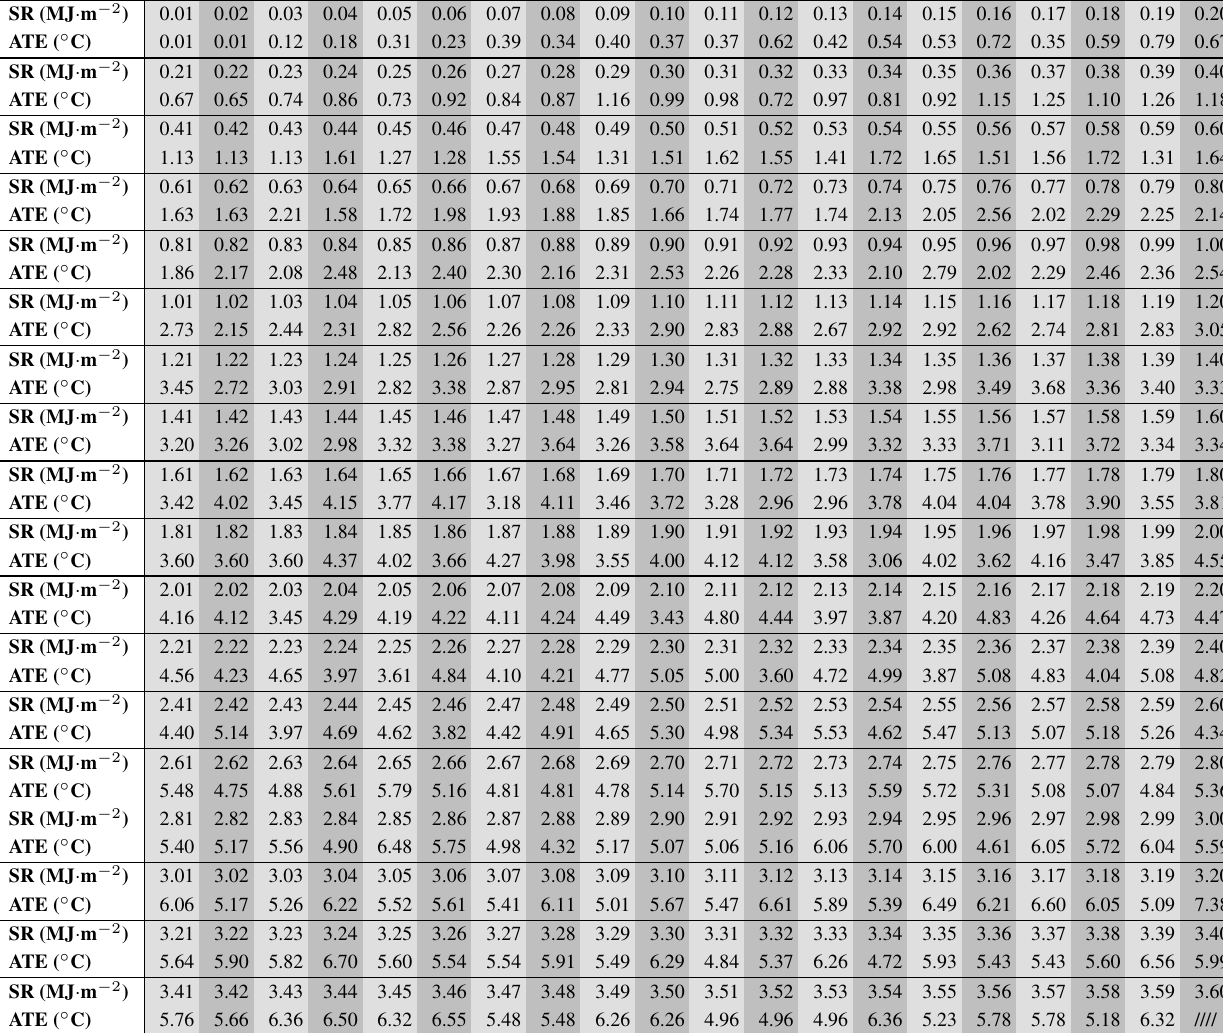
Table 2. ATE values corresponding to every possible value of SR in